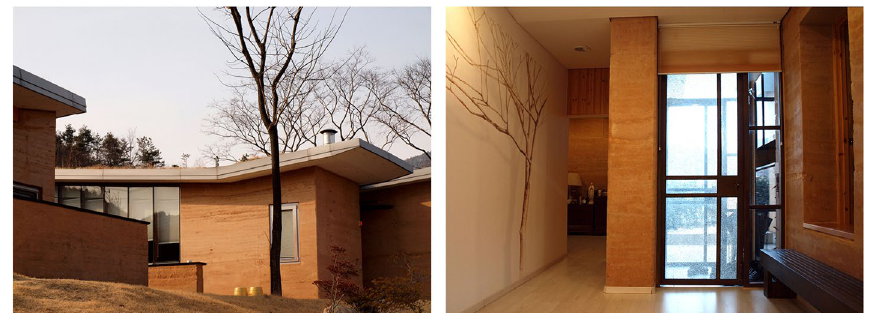
Fig. 3 Contemporary earthen houses in Korea, architect Yilwoo Lee (Source: the